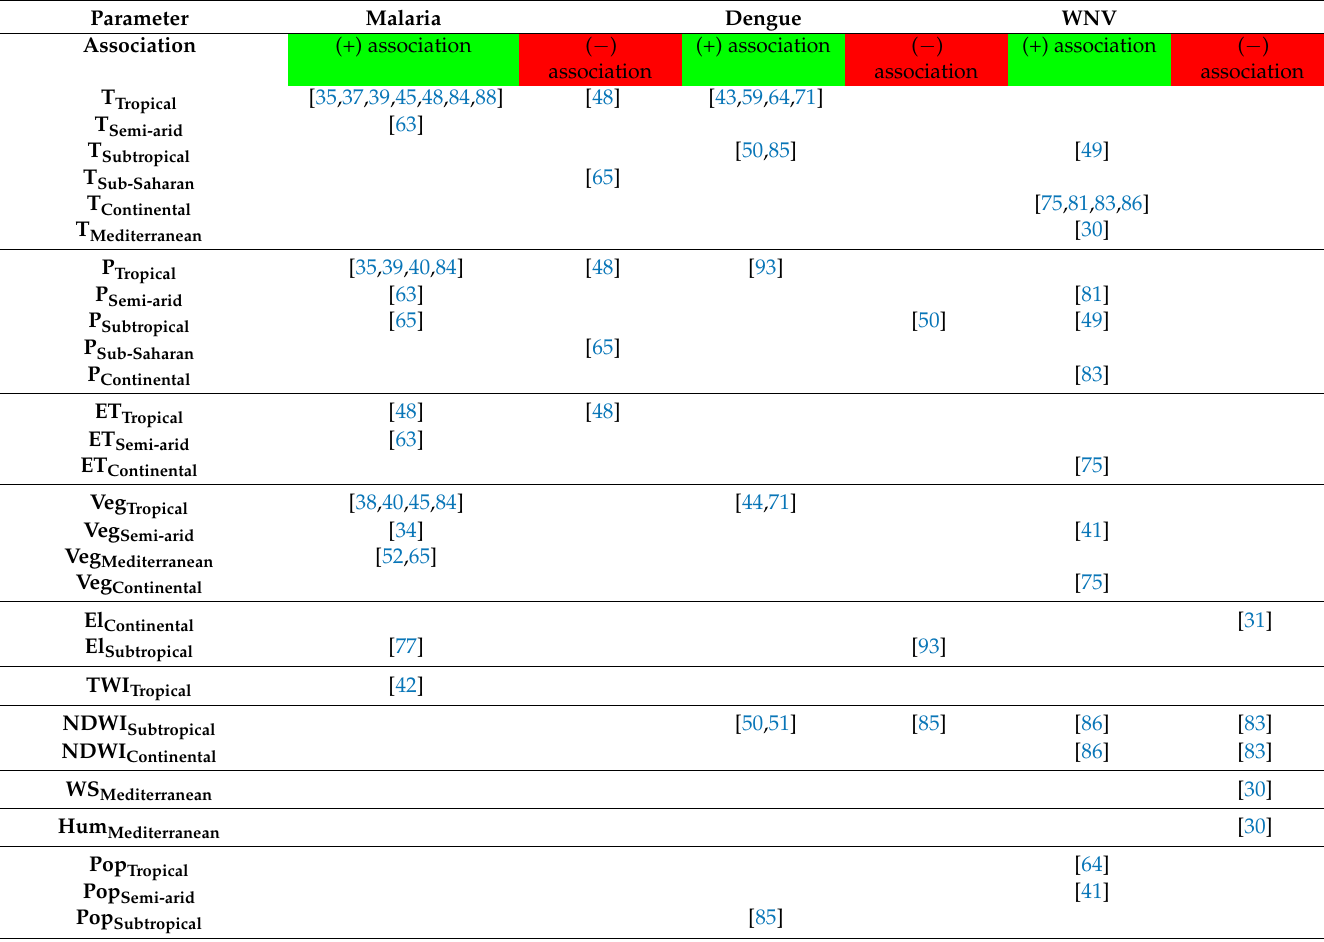
Table 2. Association between predictors and diseases; the green color shows positive association between the disease and the predictive parameter, while the red color indicates negative association in the different climatic zone. (T = Temperature, P = Precipitation, ET = Evapotranspiration, Veg = Vegetation, El = Elevation, TWI = Topographic Wetness Index, WS= Wind Speed, Hum = Humidity, Pop =